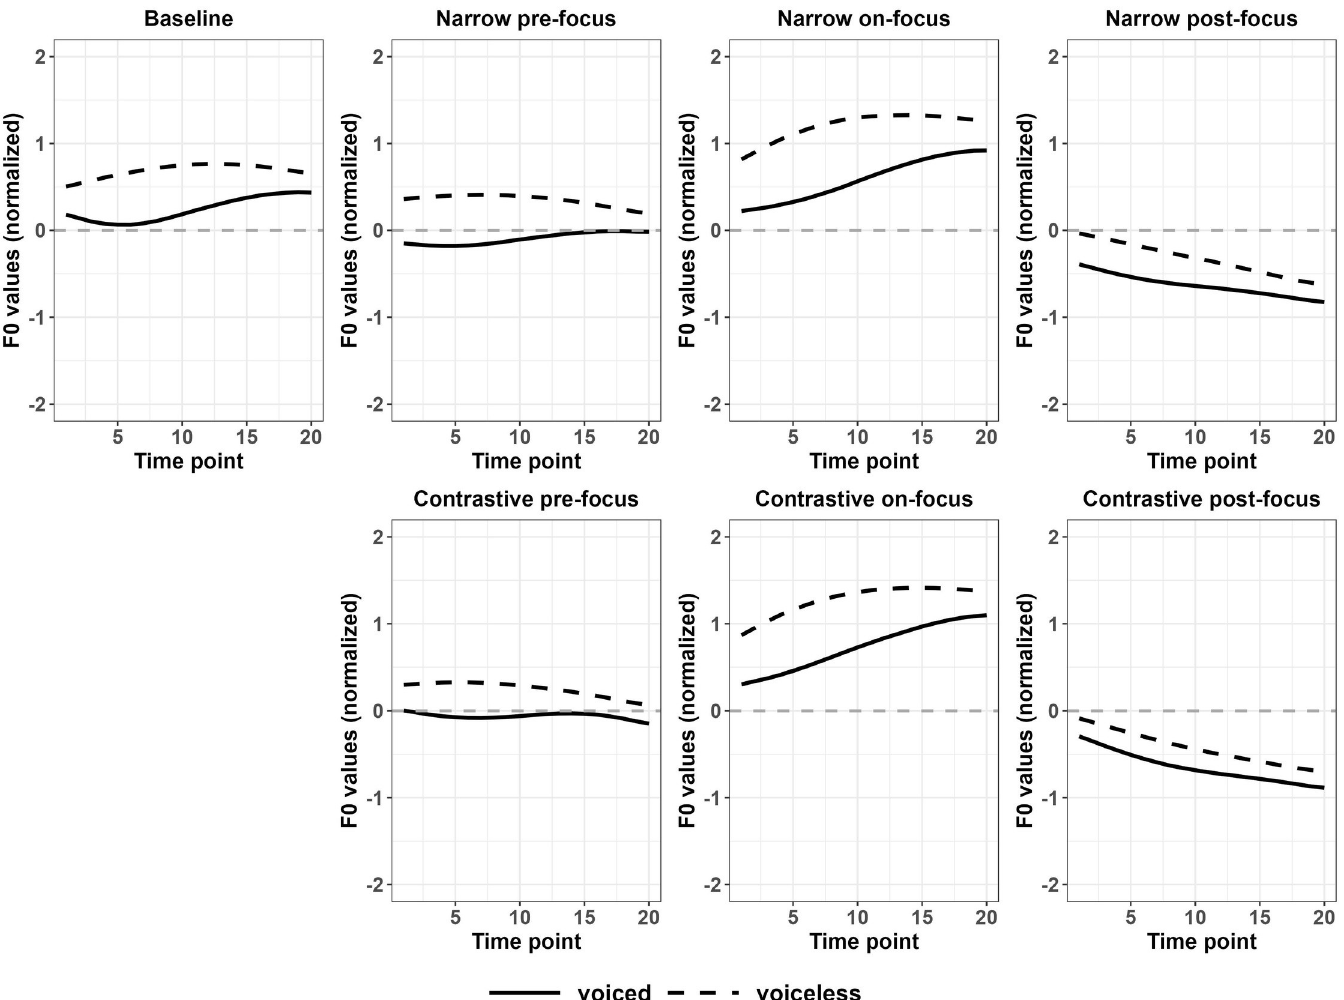
Fig 11. Normalized f0 contours of disyllabic HL targets between voiceless and voiced stops (Japanese).